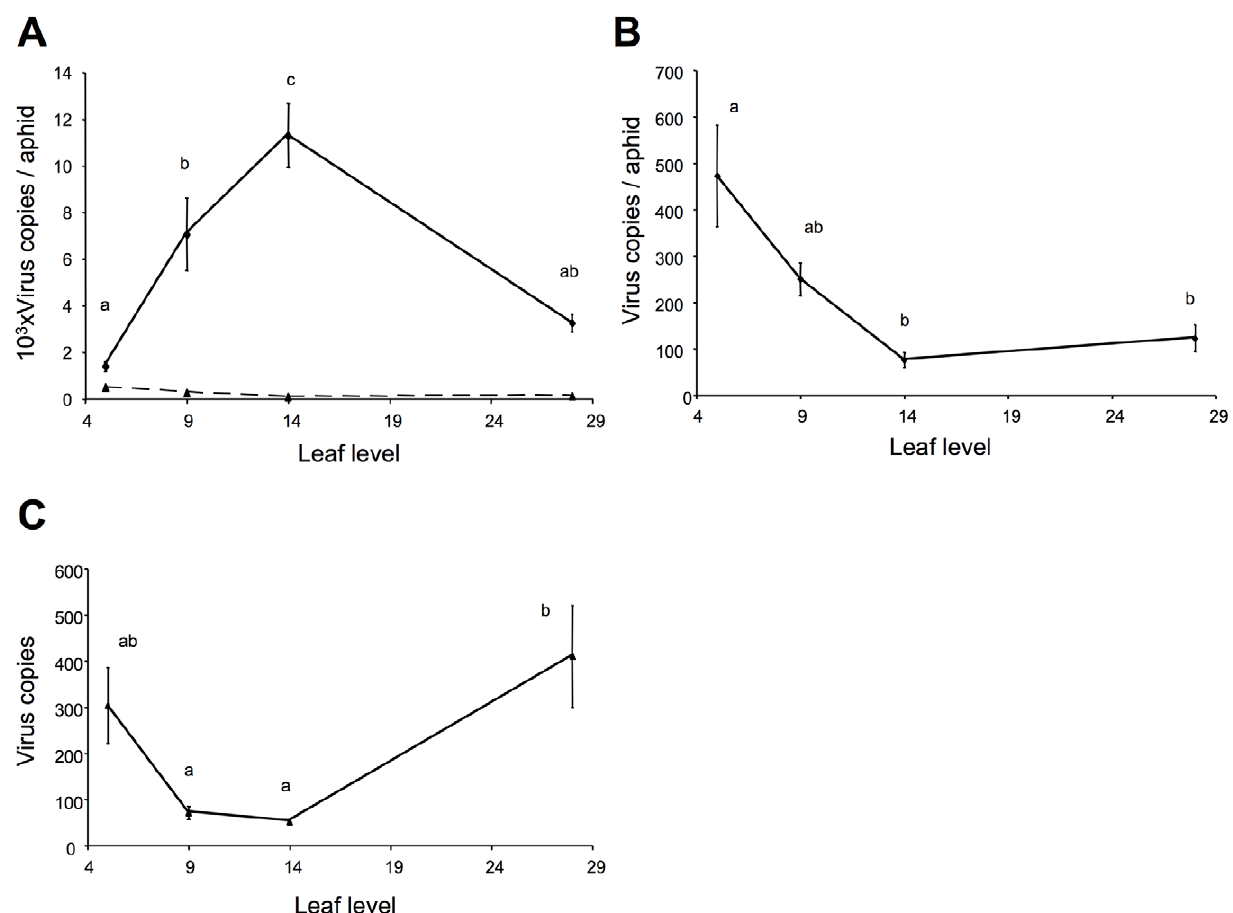
Figure 1. Dynamics of CaMV load in phloem sap. (A) Comparison of the mean virus load in aphids fed for 10 minutes (dashed line, see also B) and 16 hours (solid line) on the leaf levels indicated (vertical bars indicate standard error). The experiment was conducted in parallel on 20 plants. The difference between the two treatments was highly significant (linear mixed-effects model with leaf level and treatment as fixed effects and plant as random effect; p-value , 0.001). Significant differences were also found among viral sap loads in successive leaf levels when aphids were fed for 16 hours (Tukey’s HSD, different letters mean p-values , 0.02). Results from aphids fed for 10 min. are further considered in B. (B) This panel shows the same data as in (A), for viral sap load in aphids fed for 10 minutes, but the scale of the y-axis enlarged 20 times (Tukey’s HSD, different letters mean p-values , 0.001). (C) Virus concentration in plant cells of the same leaf and leaf levels as in (A) and (B), expressed as normalized mean virus copies per actin gene copy. Although significant differences are observed among certain leaf levels, the average cellular virus load appears relatively constant, the range falling within the same order of magnitude (Tukey’s HSD, different letters mean p-values , 0.03).